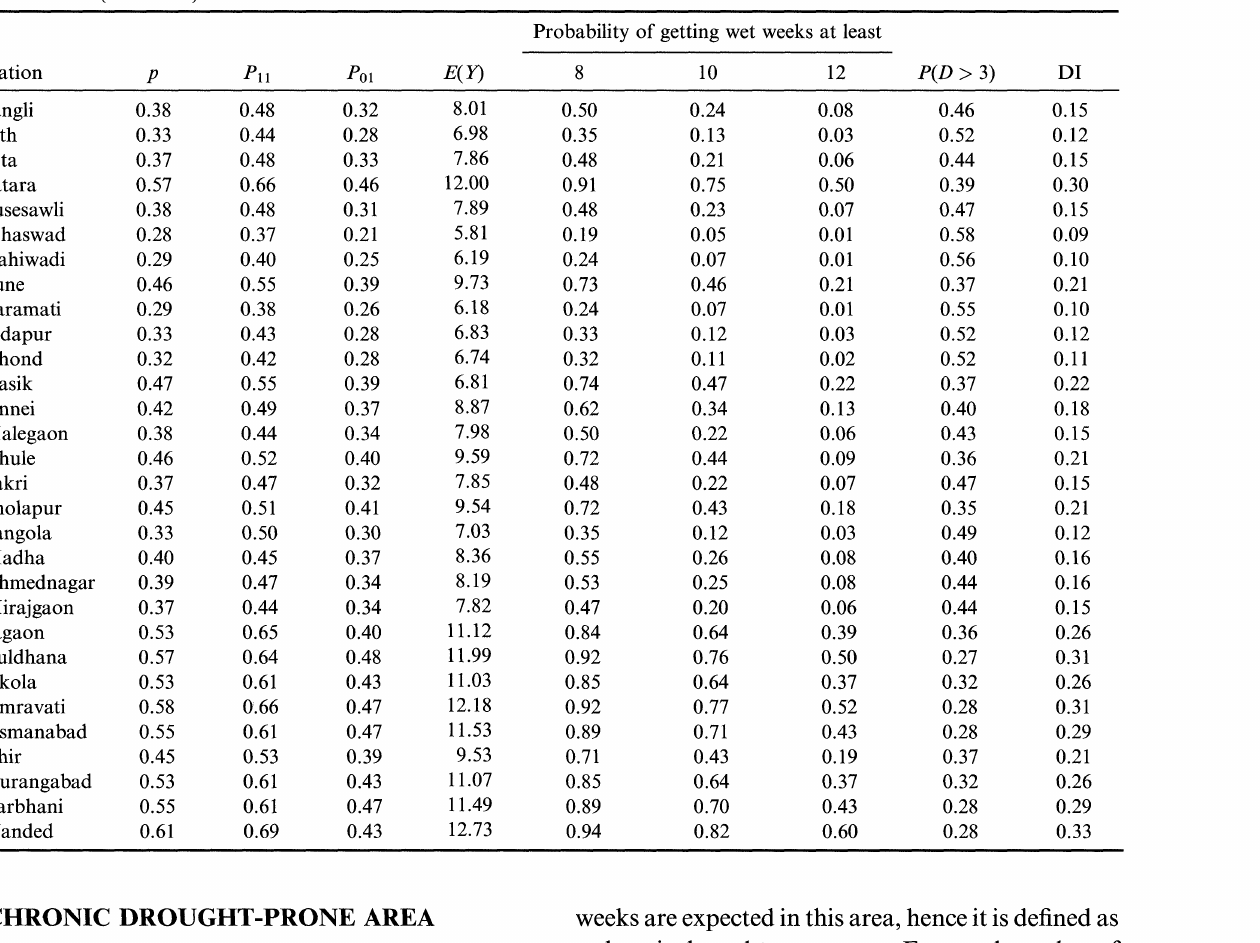
TABLE III Probability of wet and dry weeks and index of drought-proneness in various stations of dry farming tract of Maharashtra (Method 1)